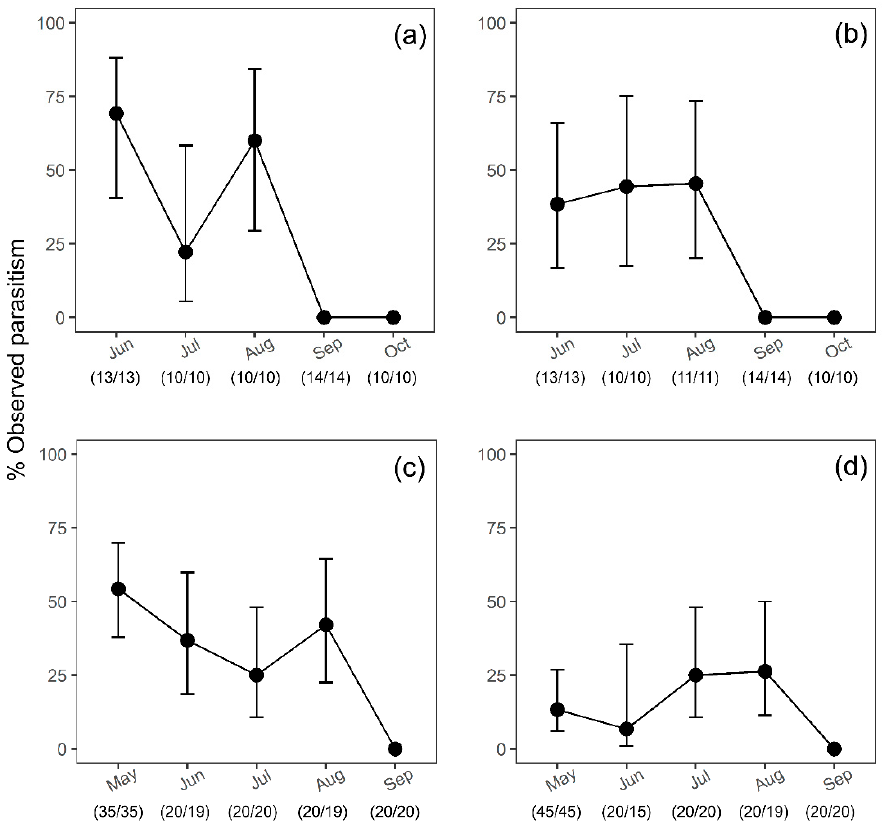
Figure 1. Estimated parasitism (with 95% confidence intervals) from sentinel Halyomorpha halys egg masses exposed to natural parasitism in Mei County, Shaanxi Province, China during egg parasitoid surveys in kiwifruit in: ( a ) 2018 organic orchard, ( b ) 2018 conventional orchard, ( c ) 2019 organic orchard, and ( d ) 2019 conventional orchard. Black circles are the back-transformed predicted means by the generalised linear model (GLM) model; the vertical lines show the back-transformed confidence intervals. Numbers in brackets indicate the number of egg masses exposed/retrieved. Overlapping confidence intervals for parasitism suggest no evidence of a statistically significant differ- ence.